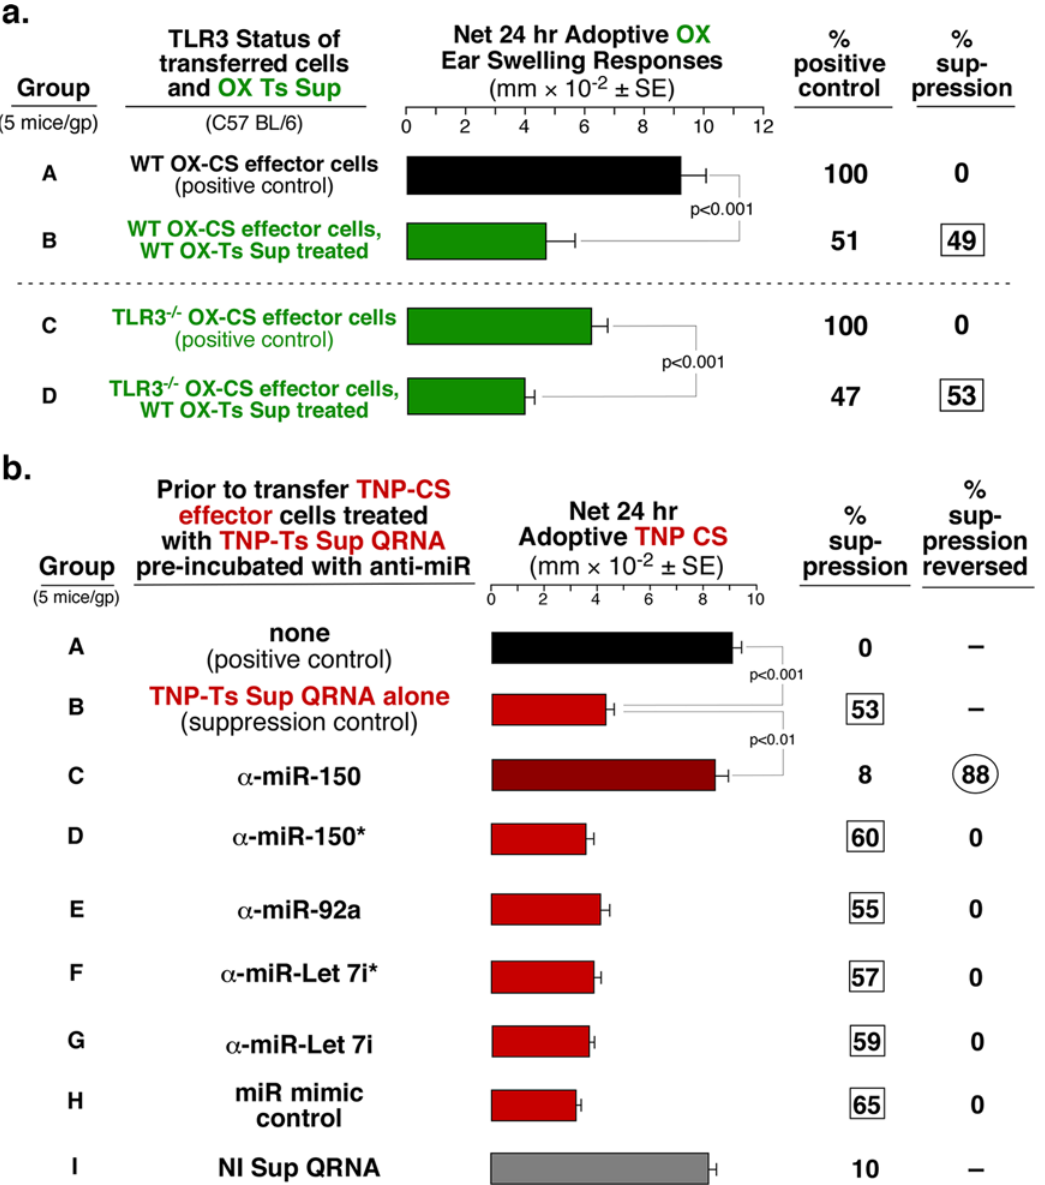
Fig 4. Suppression mediated by dsRNA is not TLR3-dependent and can be blocked by anti-miR to miR-150. a . Treatment of CS-effector cells from either wild type (WT) or TLR3 -/- mice with OX Ts Sup of WT mice results in equal suppression of the CS immune response (Group B and D). b. Among different miRNA antagonists (groups C-G), only anti-miR to miR-150 is able to reverse the suppression of CS mediated by TNP Ts Sup QRNA (group